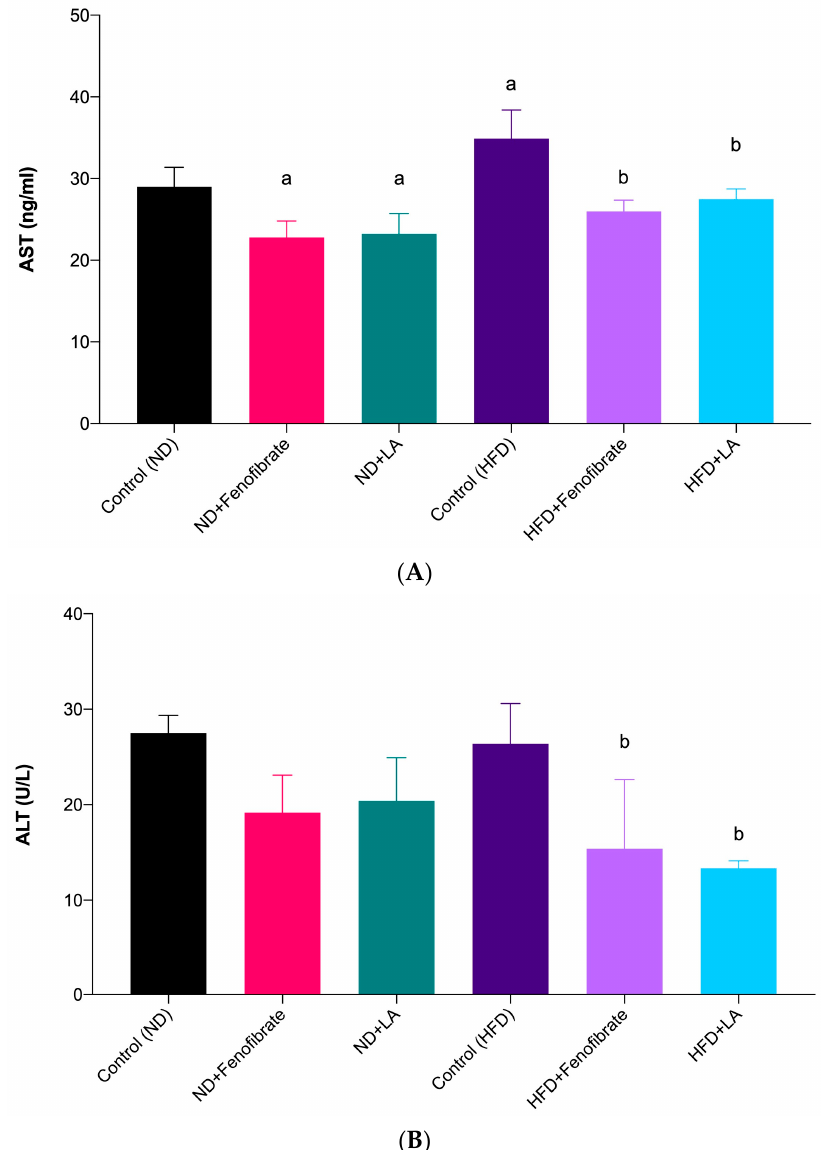
Figure 3. Serum AST levels of rats fed with a normal diet and a high-fat diet ( A ), and serum ALT levels of rats fed with a normal diet and a high-fat diet ( B ) treated with fenofibrate (60 mg/kg) and linoleic acid (5 mg/kg) for 28 days. Data are presented as mean ± SD ( n = 6). a p < 0.05 vs. Control (ND); b p < 0.05 vs. Control (HFD). Normal diet: ND; high-fat diet: HFD; linoleic acid: LA; aspartate aminotransferase: AST; alanine aminotransferase: ALT.